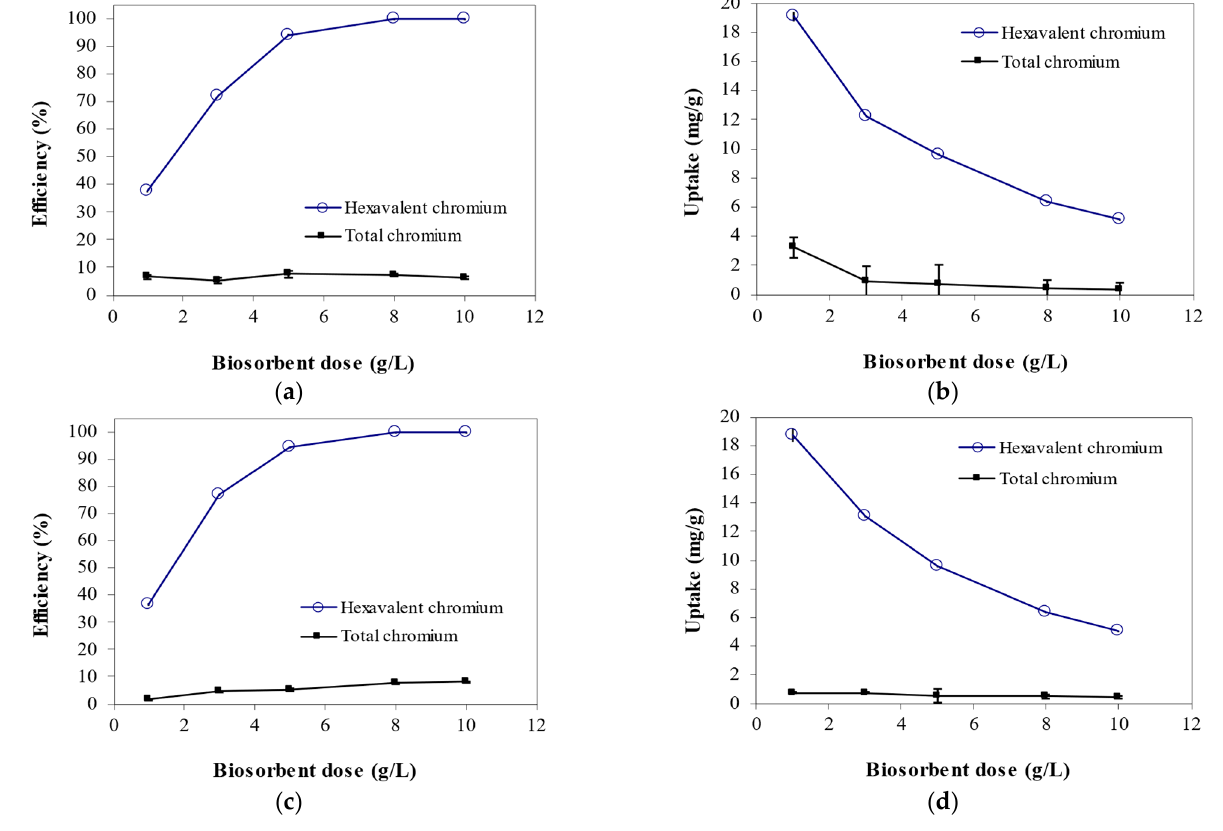
Figure 2. Effect of the biosorbent dosage on ( a ) process efficiency and ( b ) chromium uptake by Ba ‐ cillus megaterium inactive biomass and on ( c ) process efficiency and ( d ) chromium uptake by Rhodotorula sp. inactive biomass (pH = 1, contact time = 48 h, temperature = 25 °C, initial concentration = 51.04 mg/L Cr 6+ ).